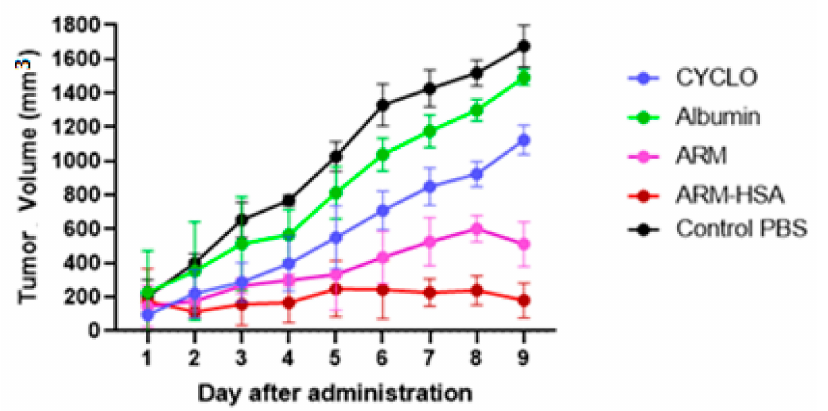
Figure 8. Results of tumor growth rate during 7 stages of drug injection. The highest tumor growth rate was in the PBS-receiving group. The lowest tumor growth rates were seen in the nanoparticle- and artemether-receiving groups, respectively.